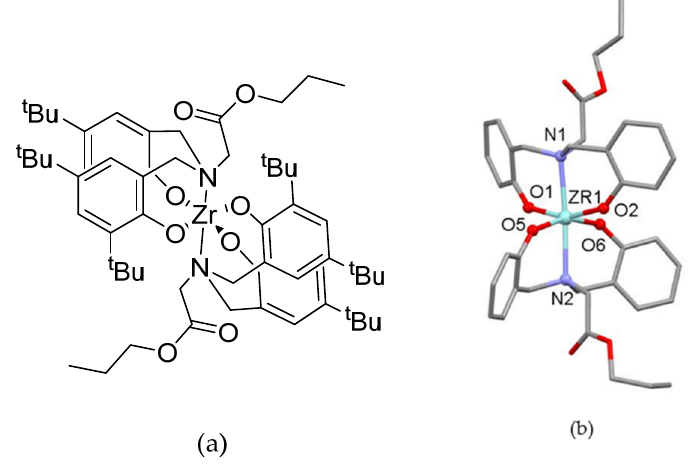
Figure 6. Zr bis(ABP) 7 ( a ), Crystal structure of 7 ( b ). Ligand structure represented by stick and Zr and atoms bound to Zr represented by ball and stick. Hydrogens and solvent omitted for clarity. Selected bond lengths for 7 (Å): Zr1-O1 2.032(3), Zr1-O2 2.030(3), Zr1-O5 2.009(3), Zr1-O6 2.013(3), Zr1-N1 2.396(3), Zr1-N2 2.398(3). Selected bond angles for 7 (°): O1-Zr1-N1 78.9(1), O2-Zr1-N1 80.0(1), N1-Zr1-N2 175.7(1).